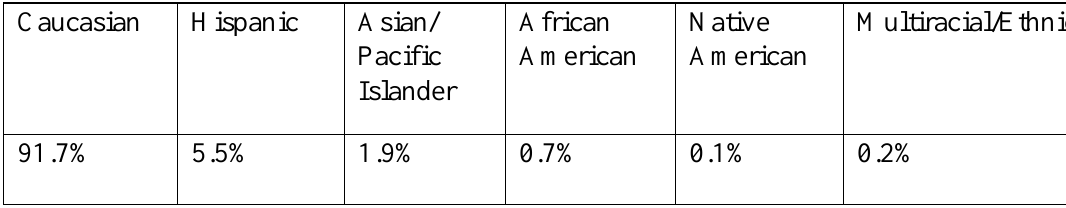
School District Background by Percentage of Students for the High School